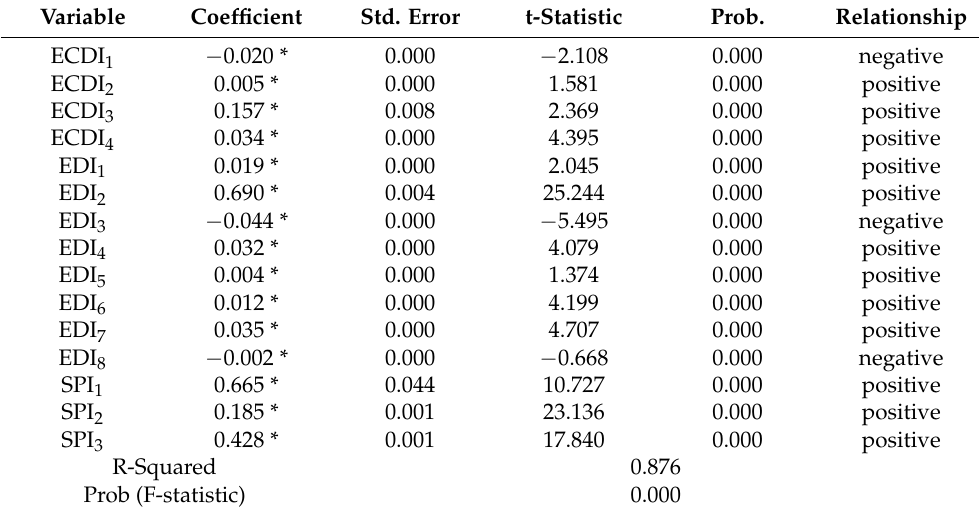
Table 5. Panel regression results for the random-effects